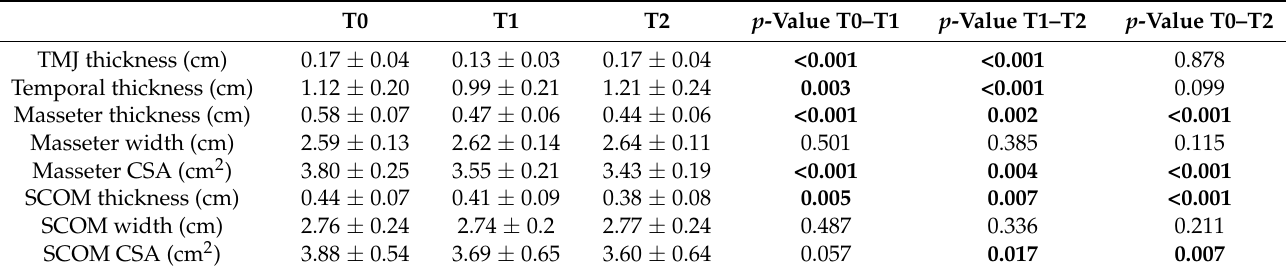
Table 3. Ultrasound (US) measurements for the intervention